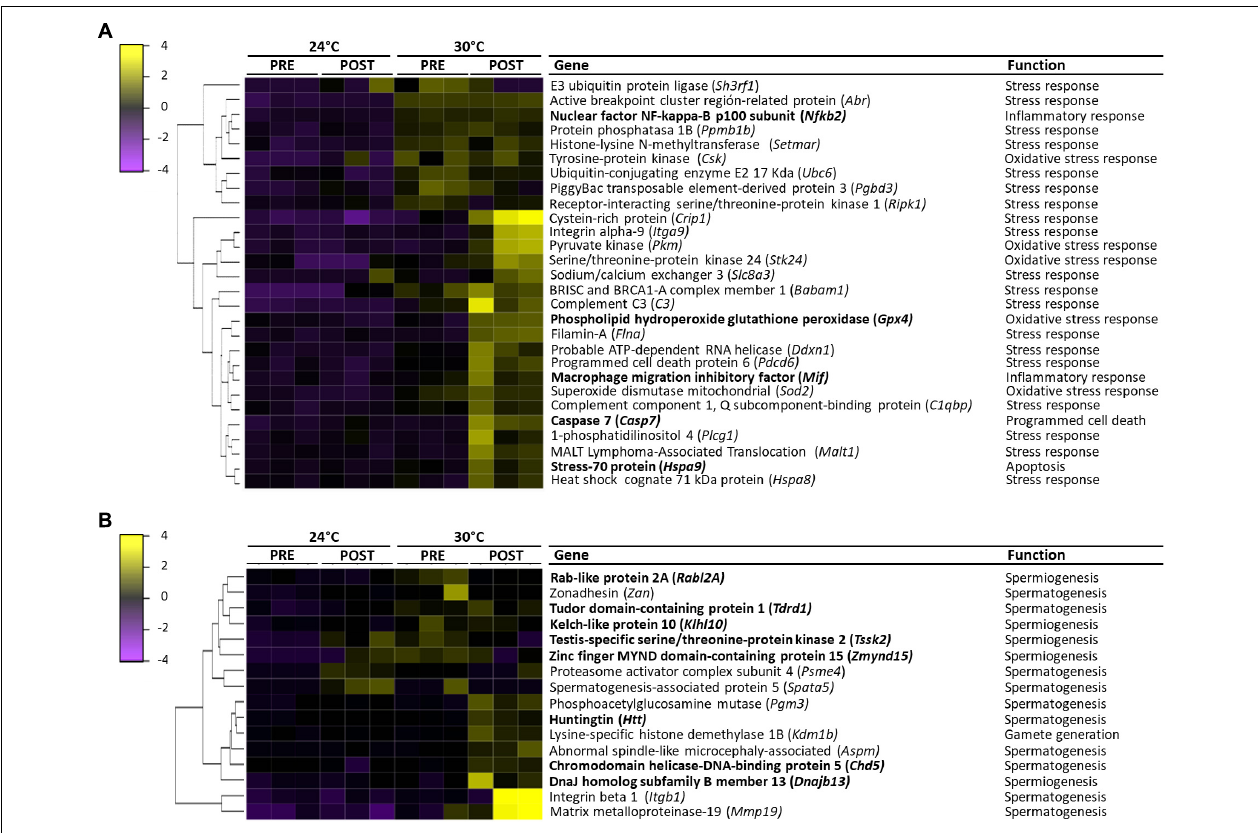
FIGURE 8 | Heatmap representing the expression values of differentially expressed transcripts (FDR < 0.05, Fold change > 2) between 24PRE, 24POST, 30PRE, and 30POST treatments and their main function. (A) Transcripts involved in the stress response. (B) Transcripts involved in reproductive process. Sample names are represented in columns and significant transcripts are represented in rows. Transcripts are clustered together based on expression similarity. Low to high expression is represented by a change of color from purple to yellow,